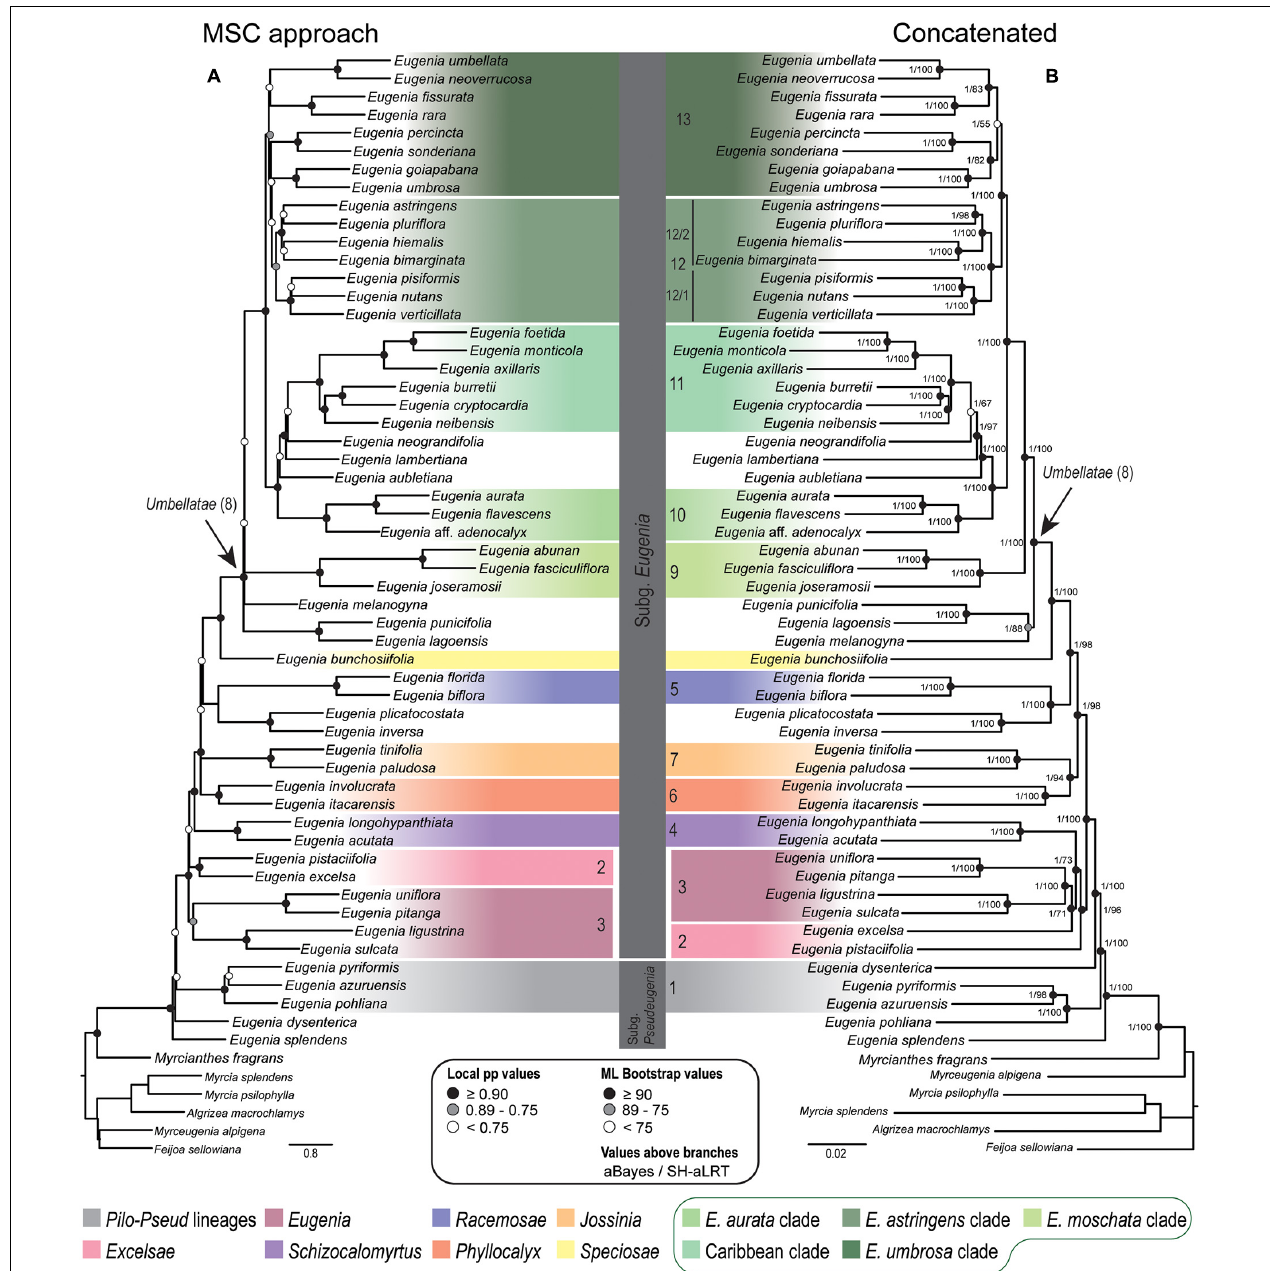
FIGURE 3 | Phylogenetic reconstructions of Eugenia based on the 239 nuclear intron regions targeted with the Angiosperm-353 probes. (A) MSC tree using Astral with support values shown at nodes as local pp. (B) Concatenated partitioned tree with ML support shown at nodes as circles (see legend) and additional tests of branch support values above branches (aBayes/SH-aLRT). Colored legend corresponds to the colored boxes (clades of Eugenia sect. Umbellatae are circled).